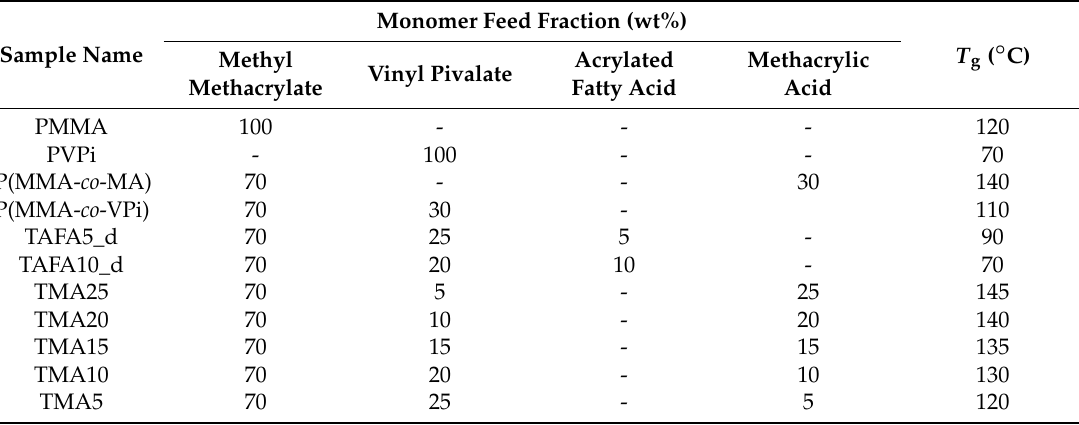
Table 3. Glass transition temperature of the polymeric